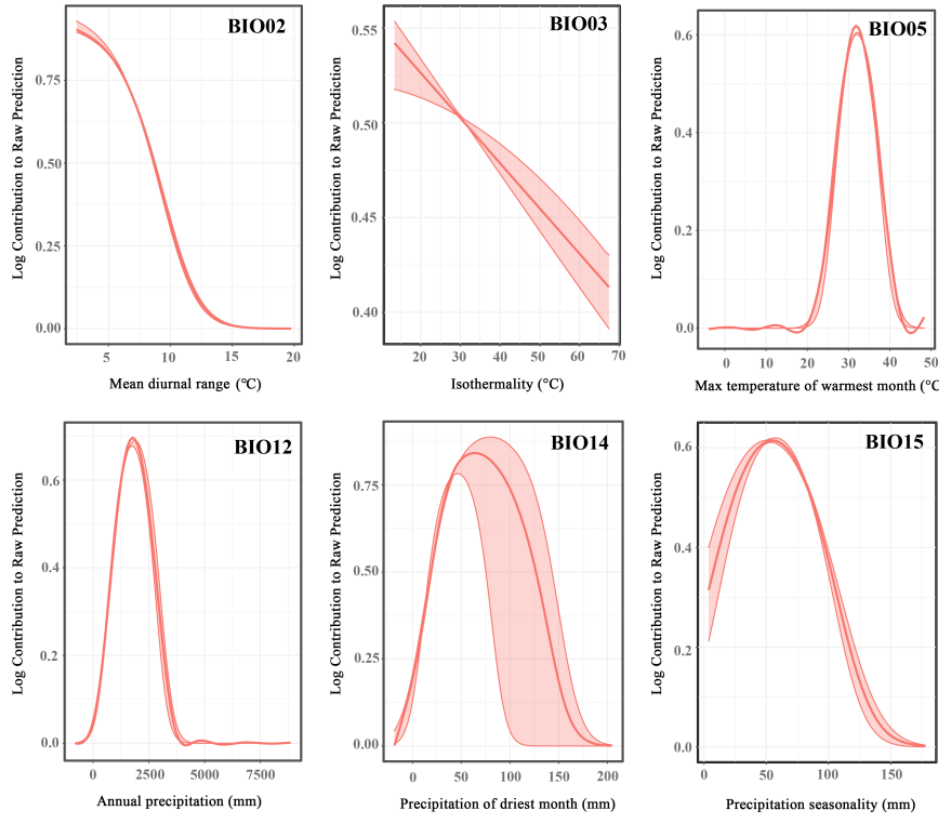
Figure 6. Response curves for representative variables. The vertical axis represents the probabil- ity of presence for Ar. subalbatus, and the horizontal axis represents the variation range of the corresponding